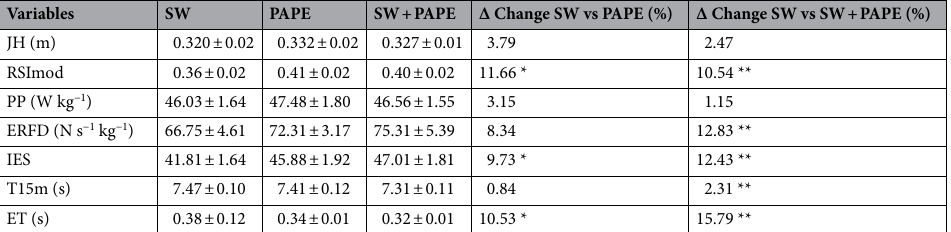
Table 1. The CMJ and 15 m swim-start performance after SW, PAPE, and SW + PAPE. The data are reported as mean ± SE. Adjustment for multiple comparisons: Bonferroni. JH jump height, RSImod the reactive strength index modified, PP peak power, ERFD the eccentric rate of force development, IES the index of explosive strength, T15m swimming start corresponding to 15 m, ET entry time. *Indicates a significant difference between the swim-specific warm-up (SW) and PAPE. **Indicates a significant difference between the swim- specific warm-up (SW) and the swim-specific warm-up with PAPE (SW +